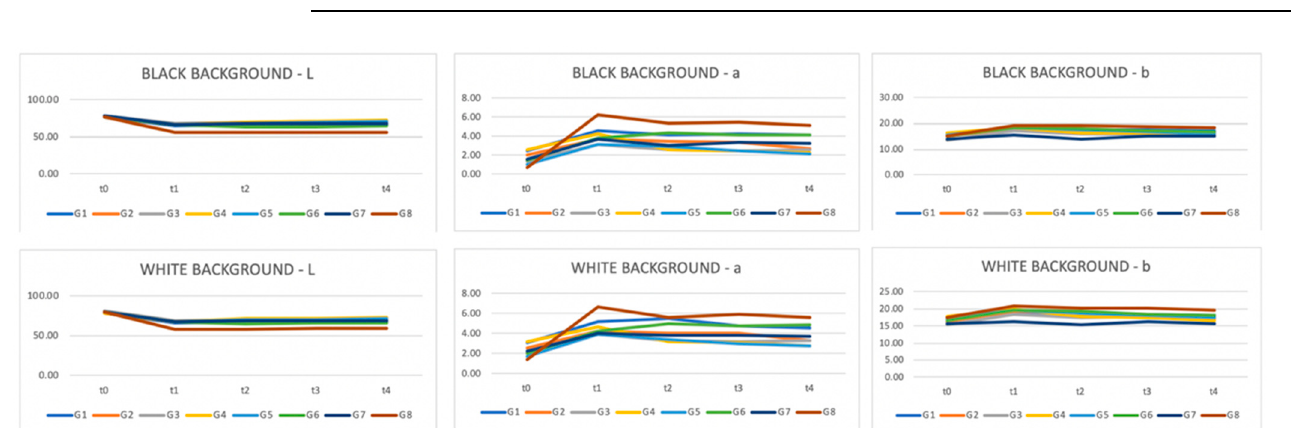
Figure 4. Average color difference in terms of CIEDE00 (t0-t1) according to different staining liquids analyzed over a black background. Vertical bars denote 95% confidence intervals.